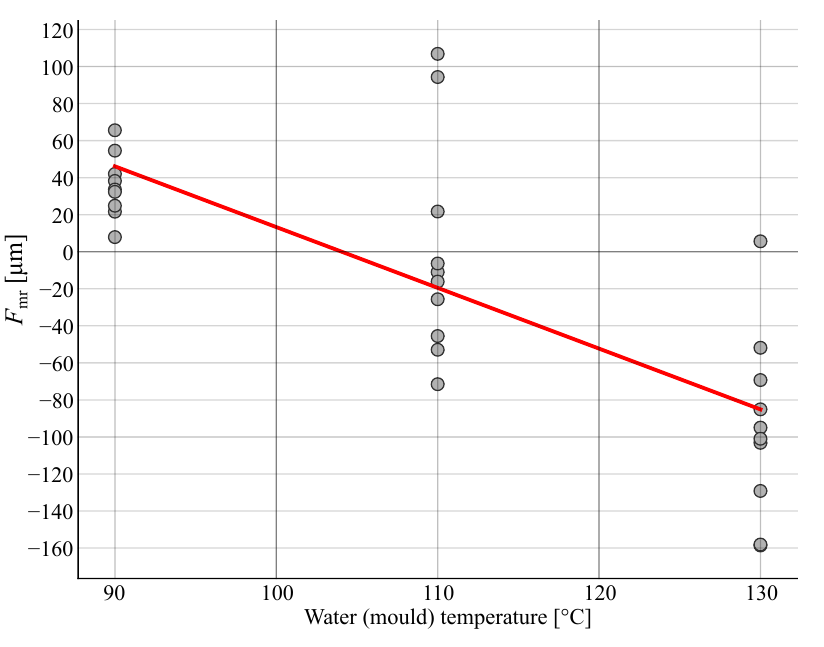
Figure 8. Dependency of the parameter F mr to the water (mould) temperature. The coefficients of the linear regression for parameter F mr are shown in Equation